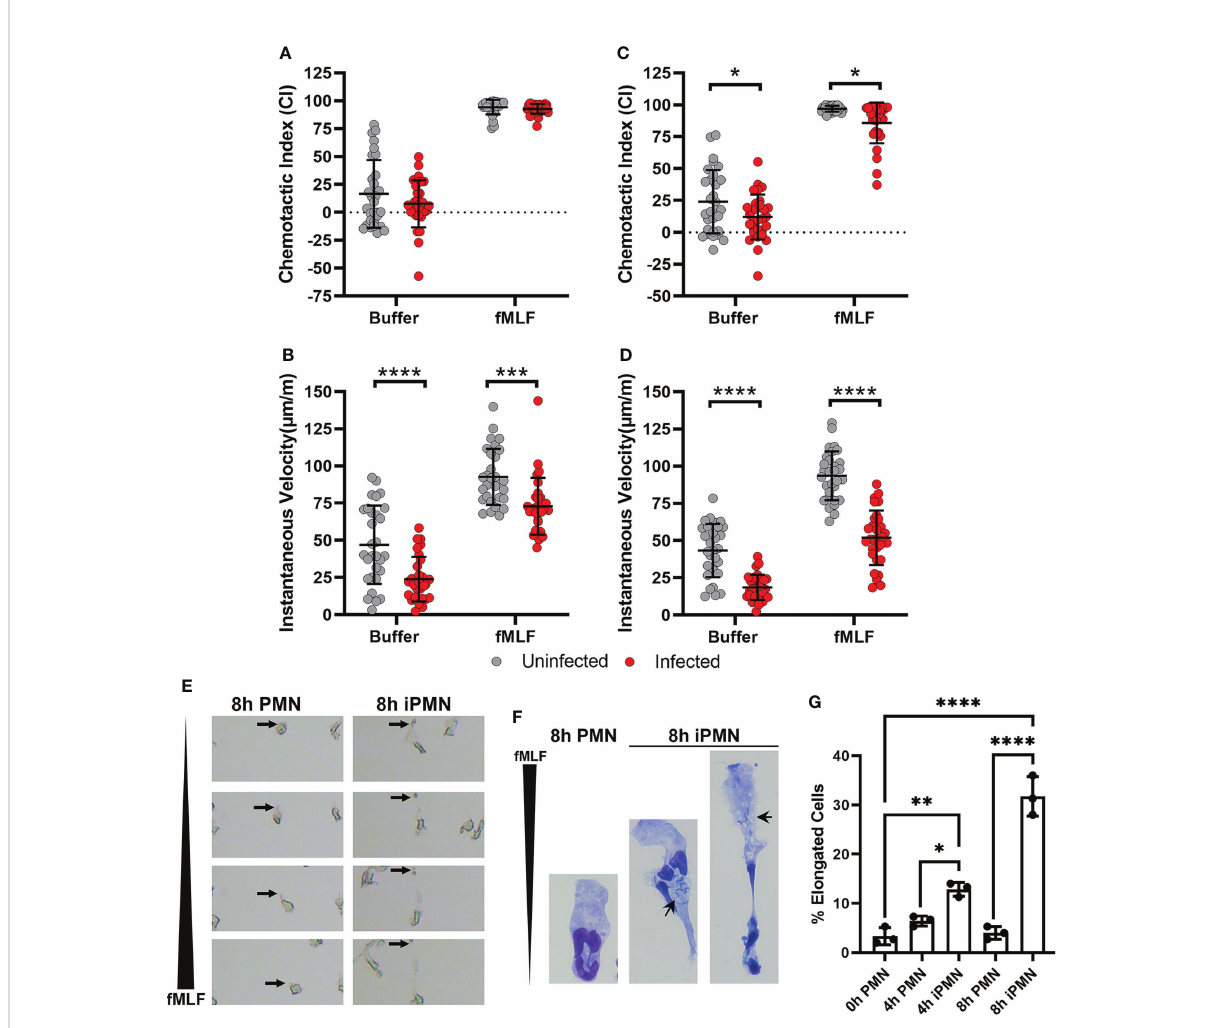
FIGURE 1 Chemotaxis of H . pylori -infected neutrophils to fMLF is impaired. (A – E) PMNs were left untreated or infected with H . pylori for 4 (A, B) or 8 hours (C – E) at 37°C prior to analysis of cell migration toward fMLF or buffer using an EZ-TAXIScan ™ live cell imaging system. Single cell tracking was used to determine chemotactic indices (A, C) and instantaneous velocities ( m m/min) (B, D) . Graphs show the mean ± SD from three independent experiments. Symbols are data for individual cells. Statistical signi fi cance was determined by two-way ANOVA and Tukey ’ s multiple comparison ’ s post-test: * p <0.05,*** p <0.001, **** p <0.0001, as indicated. (E) Still images from EZ-TAXIScan ™ videos show the morphology of representative control and infected cells migrating toward fMLF at 8 hours after isolation or initiation of infection. Arrows mark the trailing uropod of each cell. (F) Hema-3 staining shows the morphology of control and infected cells that migrated toward fMLF in the under-agarose assay. Arrows point to bacteria in infected cells. (G) Pooled under-agarose assay data indicate the percentage of elongated cells at each assayed time point as the mean ± SD from three independent experiments. Statistical signi fi cance was determined by two-way ANOVA and Tukey ’ s multiple comparisons post-test. * p <0.05, ** p <0.01, **** p <0.0001, as indicated. iPMN, infected PMNs. Long black wedges indicate the fMLF concentration gradient in panels (E, F)